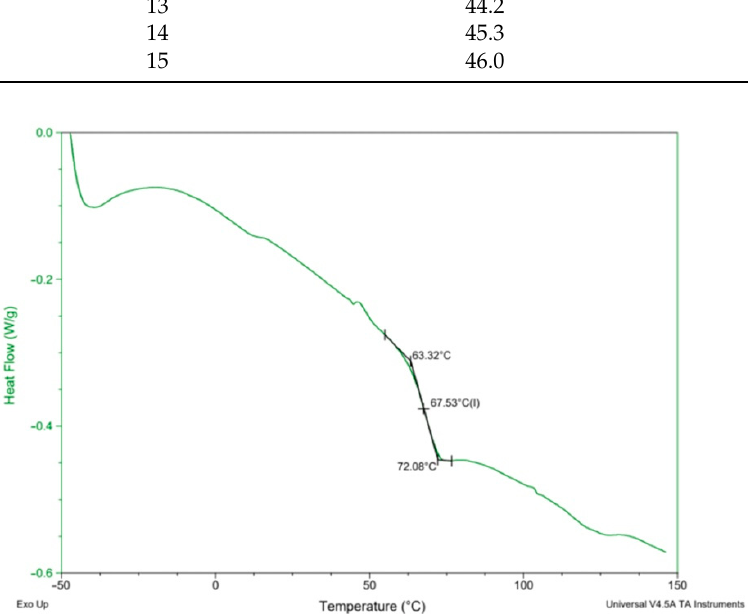
Figure 8. Glass transition temperatures (Tg) of the obtained PHUs. The data in Table 5 and Figure 8 indicate three types of the polymers resulting from the reagents’ compositions. The first group are thermoplastics synthesized in run nos. 5 (120 °C, 90 min), 6 (160 °C, 90 min), 9 (140 °C, 60 min), 10 (140 °C, 120 min), where DCBPA was used, which exhibit Tgs in the range between 0 °C and 10 °C. What is worth noting is that both the temperature increases and prolonged reaction time resulted in just slight increase in the Tg. The experiment run nos. 1 (120 °C, 60 min), 2 (160 °C, 60 min), 3 (120 °C, 120 min), 4 (160 °C, 120 min), 13, 14 and 15 (140 °C, 90 min) with equimolar mixture of BGC/DCBPA yielded PHUs of Tgs between 40 °C and 50 °C. The effect of reaction temperature increase resulted in a slight decrease in the Tg of the product.